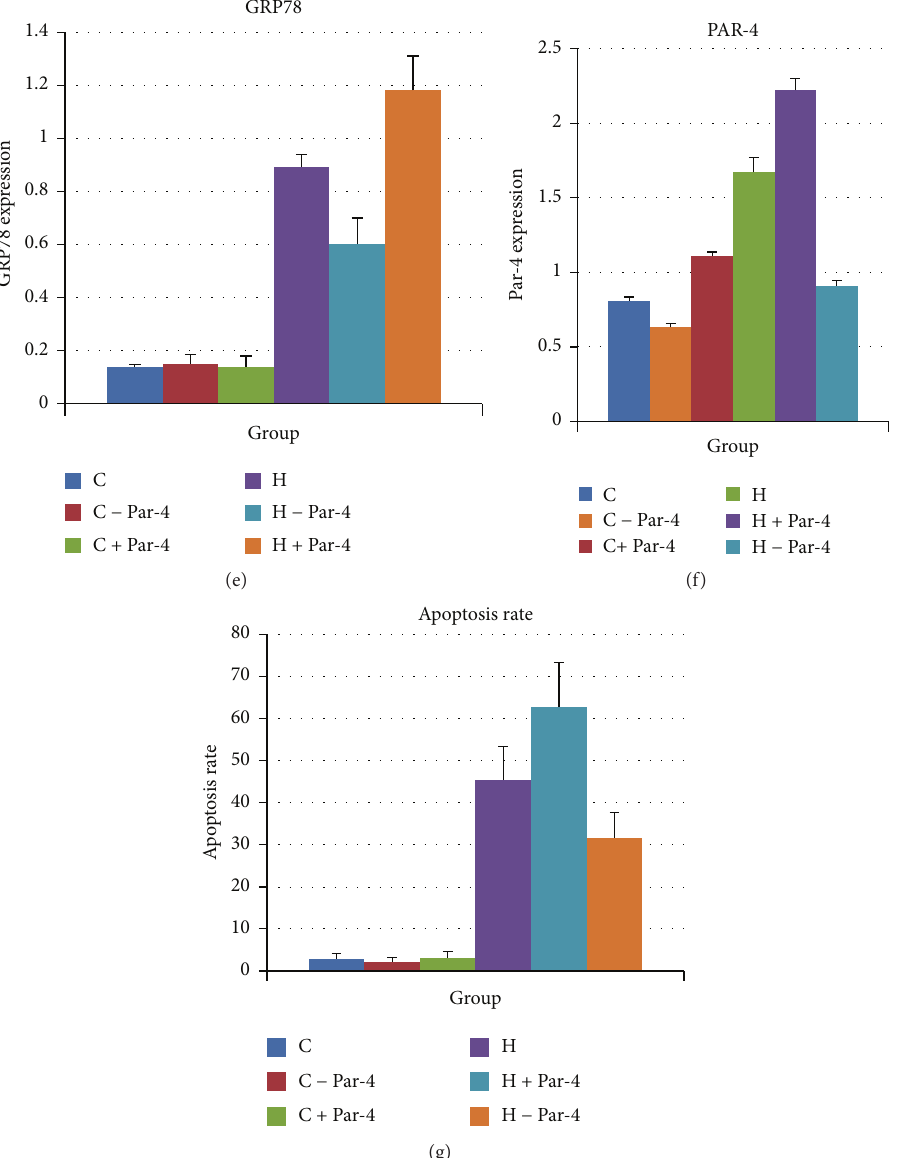
Figure 2: Par-4 is involved in the glucose and palmitate coinduced apoptosis of NIT-1 and insulin secretion.